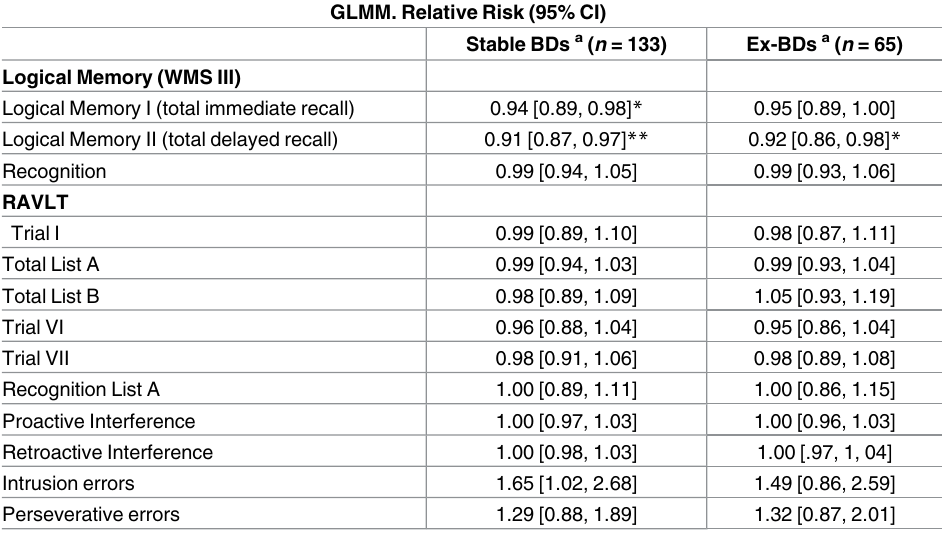
Table 3. Generalized linear mixed models for neuropsychological scores and BD